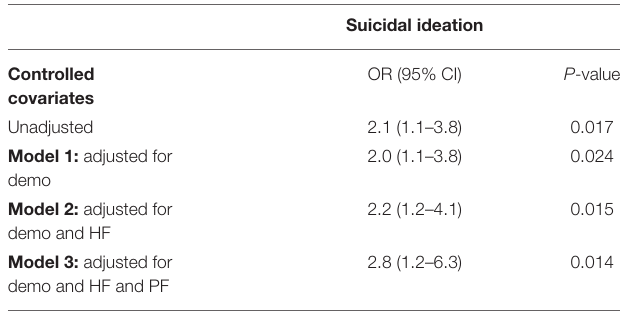
TABLE 3 | Multivariable logistic regression analysis, demonstrating the independent association of aura on suicidal ideation.